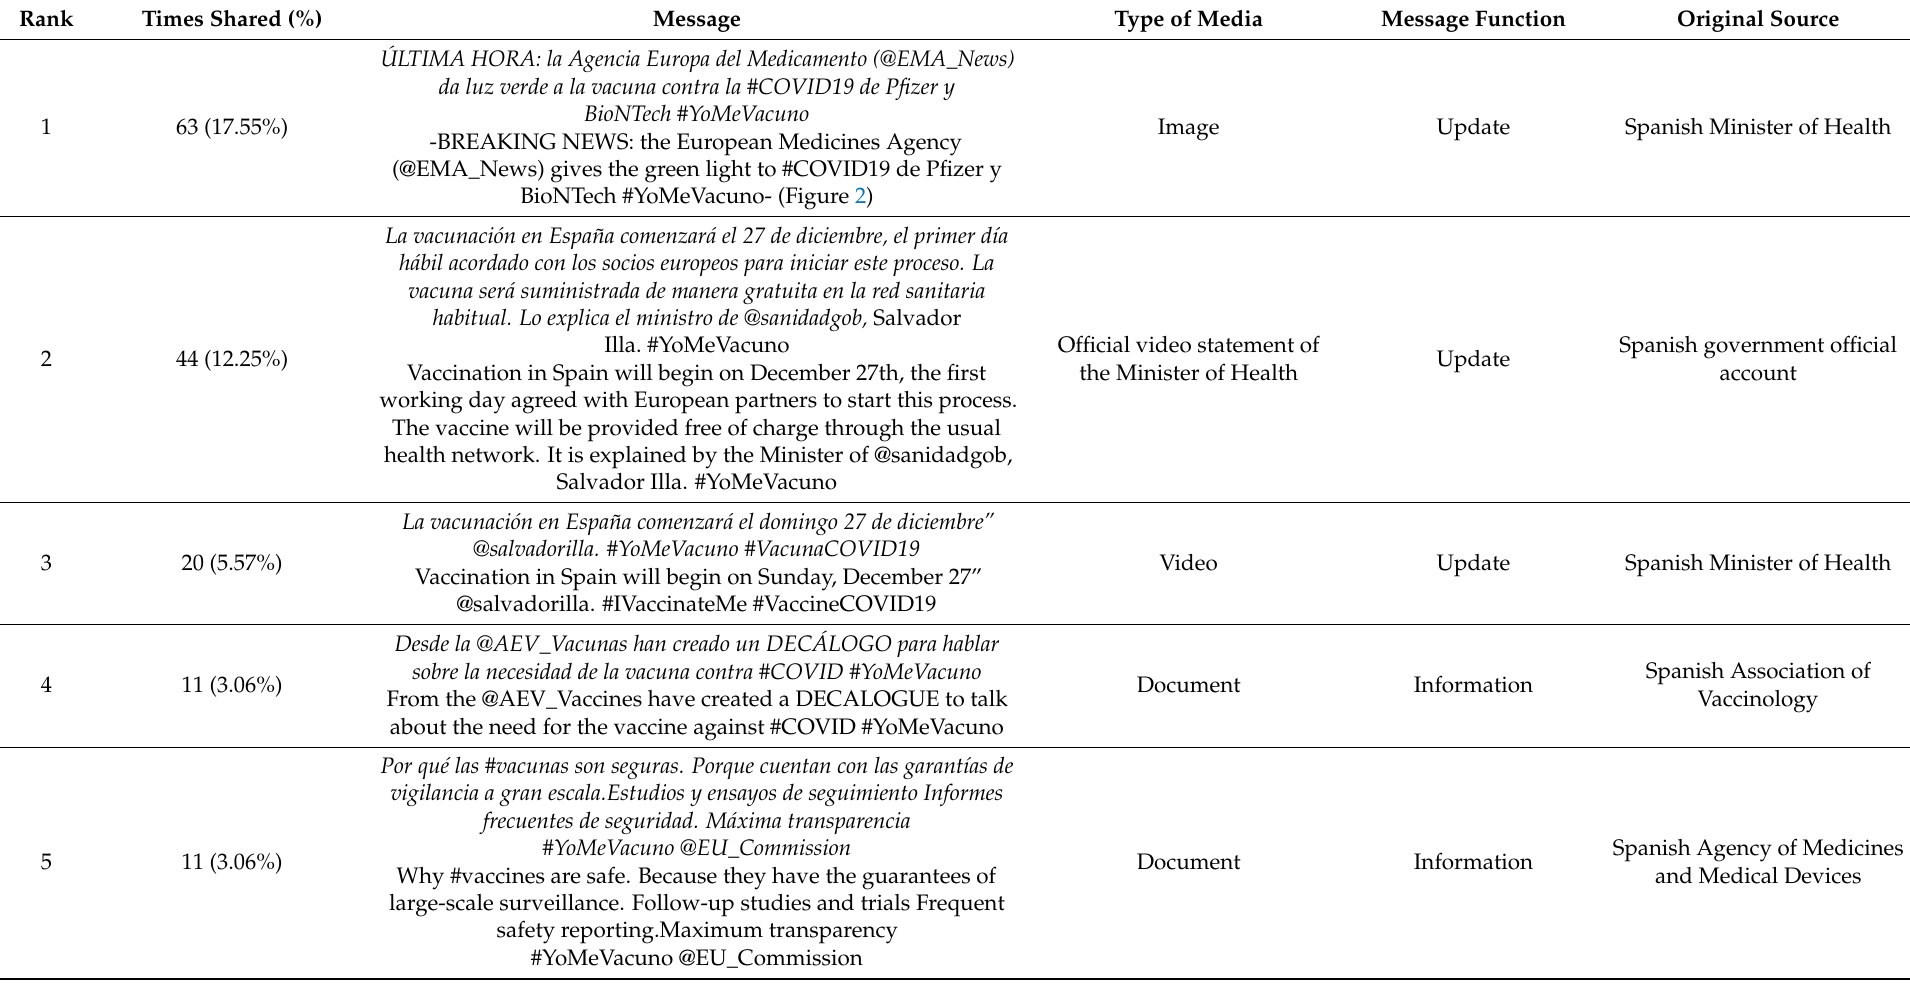
Table 4. Most shared tweets by healthcare professionals in #yomevacuno